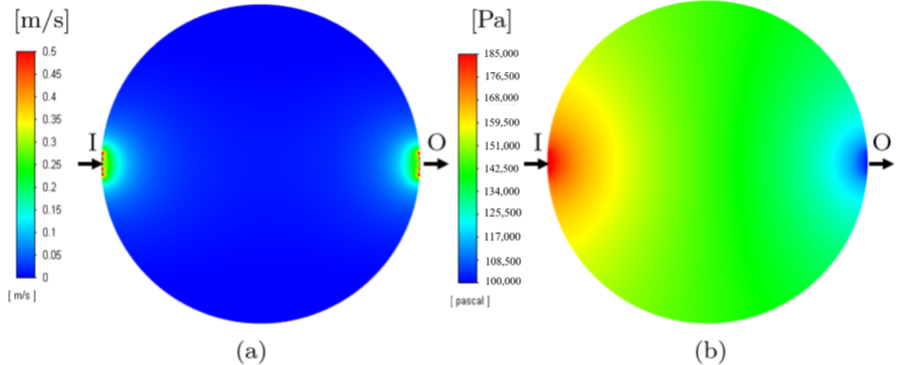
Figure 9. Distribution of ( a ) velocity and ( b ) pressure of the porous volume